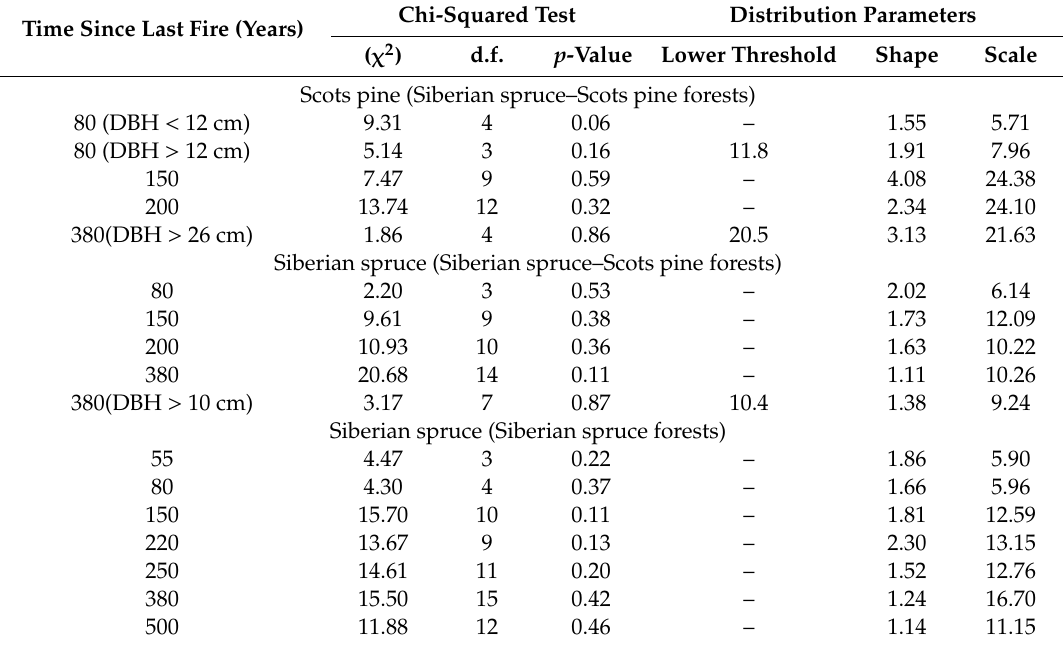
Table 3. Results of approximation of the DBH distributions by Weibull distribution with two and three